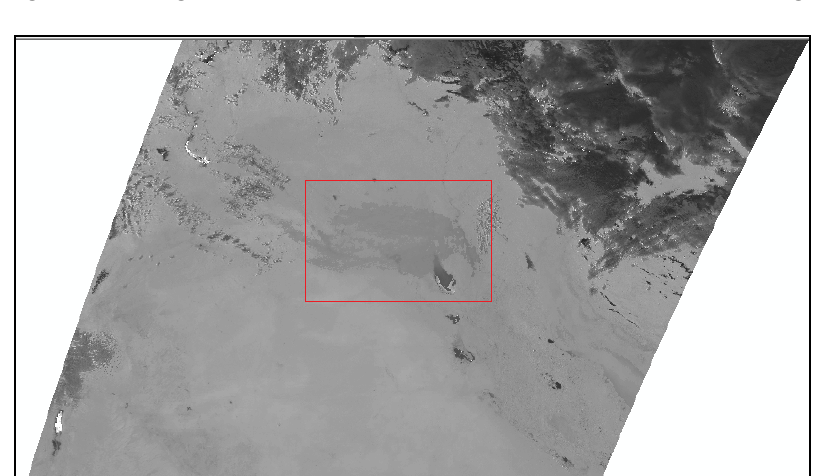
Fig. 5: Effecting NDDI index on 16/6/2016 MODIS terra satellite image.